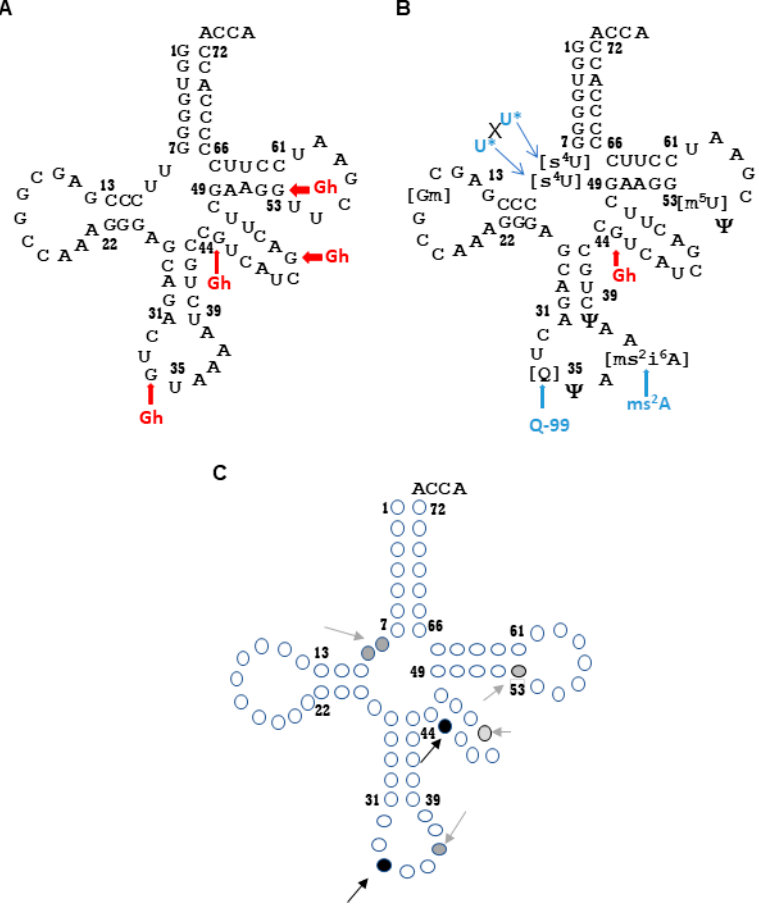
Figure 1. Hotspots of photooxidative damage in tRNA Tyr . Following UVA exposure in the presence of a photosensitizer, either ( A ) unmodified (in vitro transcript of tDNA Tyr ) or ( B ) modified tRNA Tyr was digested with RNase cusativin or T1 and subjected to liquid chromatography–tandem mass spectrometry (LC–MS / MS) analysis. Mapping the observed digestion products to the original sequence identified the locations of photooxidative damage accumulation. ( C ) Hotspots of UVA-induced photooxidative damage on a generic tRNA. Nucleotides are represented in circles. The most susceptible nucleotides in specific regions are shown as dark black circles; nucleotides that are susceptible due to specific modifications or variable susceptibility at specific locations are shown as grey circles. Gh: 5-guanadinohydantoin; U*XU*: crosslinked uridine; Q-99: queuosine-99 Da; ms 2 A: 2-methylthioadenosine.